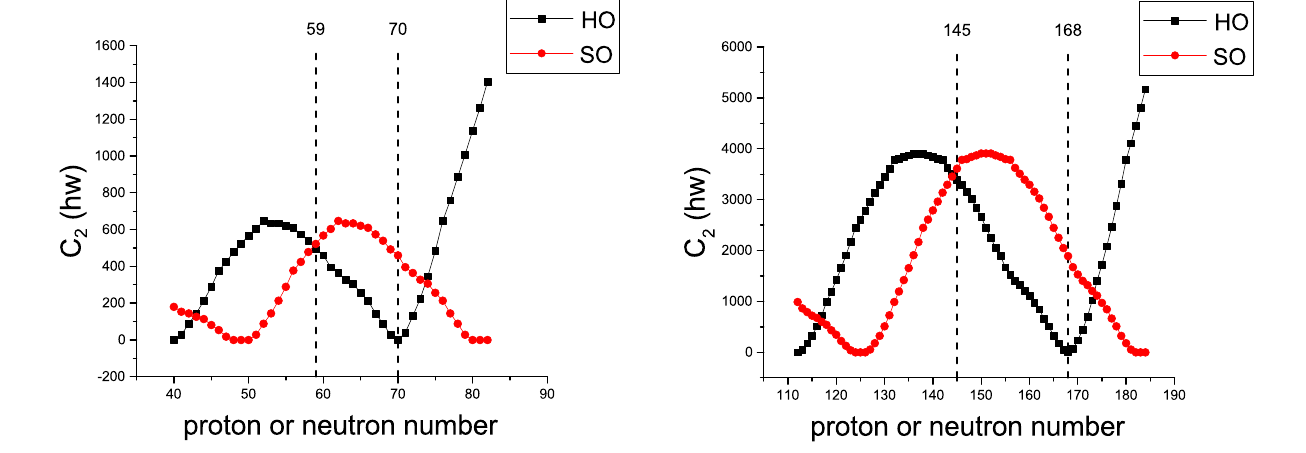
Figure 4. The same as Fig. 1. An island of shape coexistence is predicted within proton or neutron numbers 59 − 70.